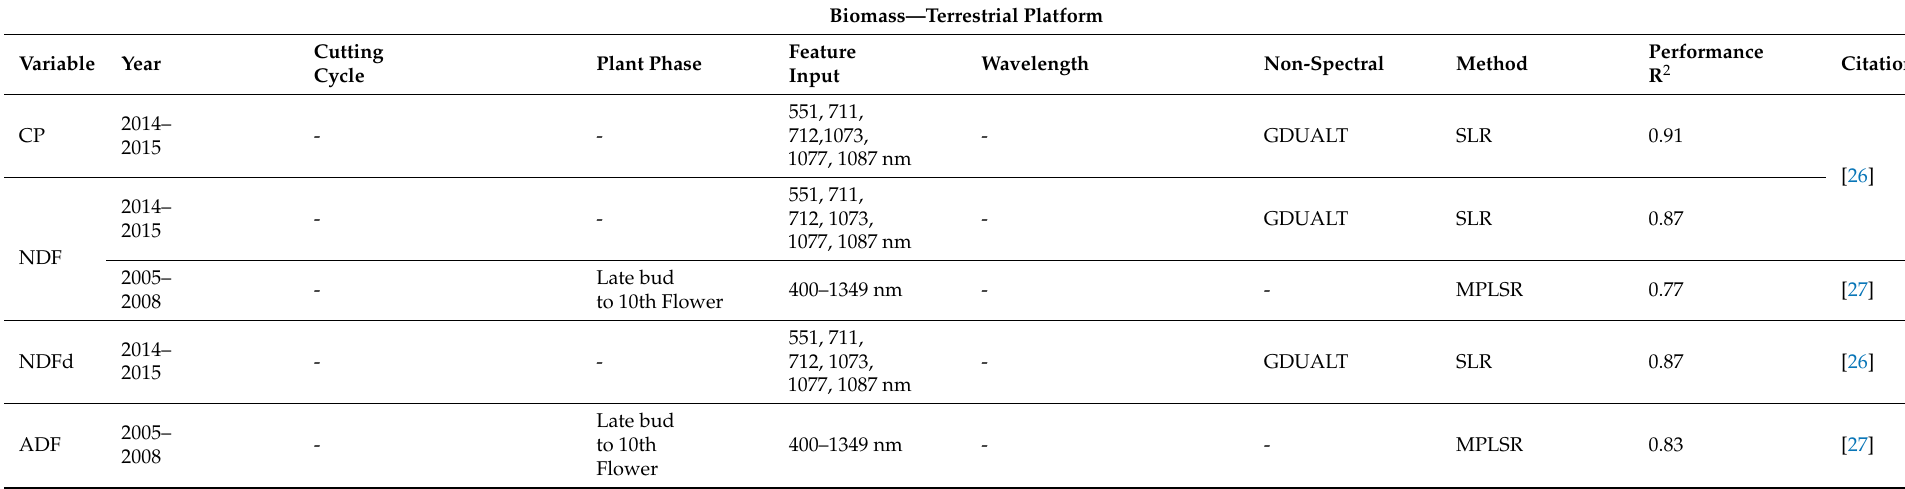
Table A4. Most accurate features for predicting alfalfa quality traits using terrestrial platforms.